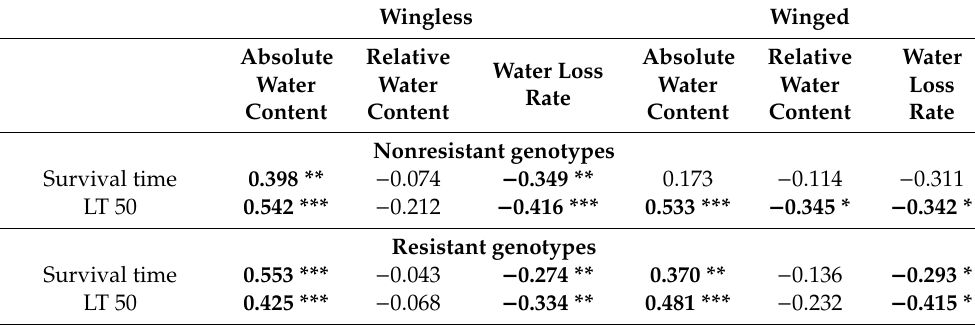
Table 2. Correlations between desiccation-related traits of winged and wingless Sitobion avenae for resistant and nonresistant genotypes. Wingless Winged